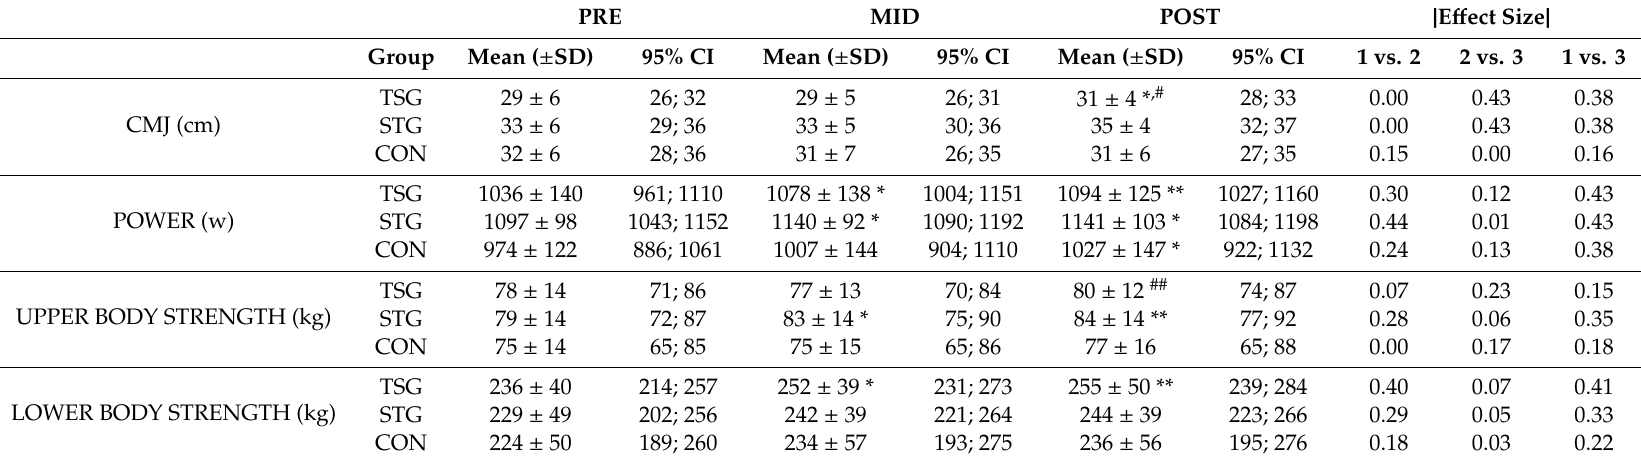
LOWER BODY STRENGTH (kg) CMJ, countermovement jump; POWER, maximal 6 s power cycling; UPPER BODY STRENGTH, maximal isometric bilateral extension; LOWER BODY STRENGTH, maximal bilateral extension; TSG, task specific group; STG, strength training group; CON, control group. * = compared to PRE values * = p < 0.05, ** = p < 0.01; # = compared to MID values, # = p < 0.05, ## p <